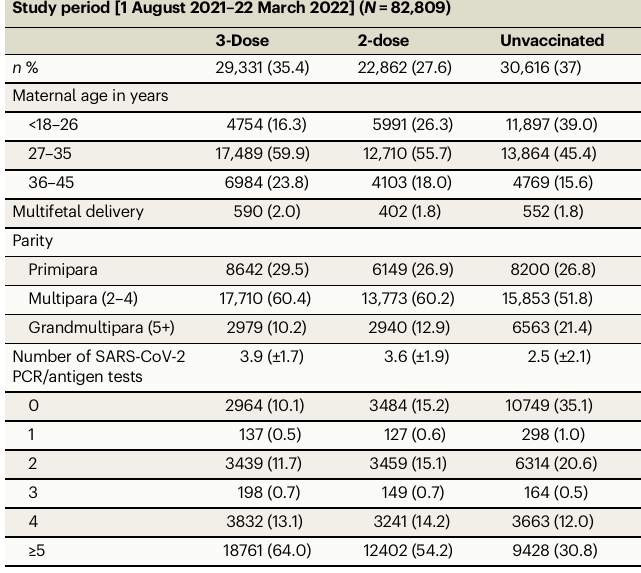
Data are n (%), and mean (±standard deviation);data arecalculated according to thevaccine status of women at delivery.